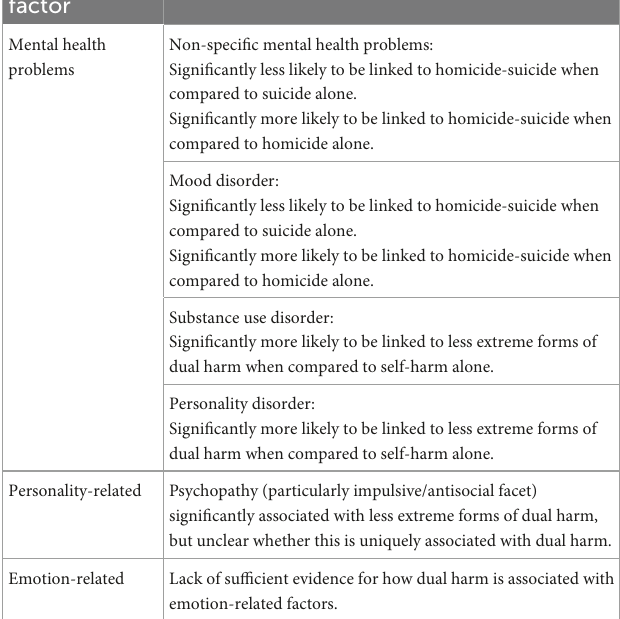
TABLE 4 Summary of identified trends. Psychological Summary of factor